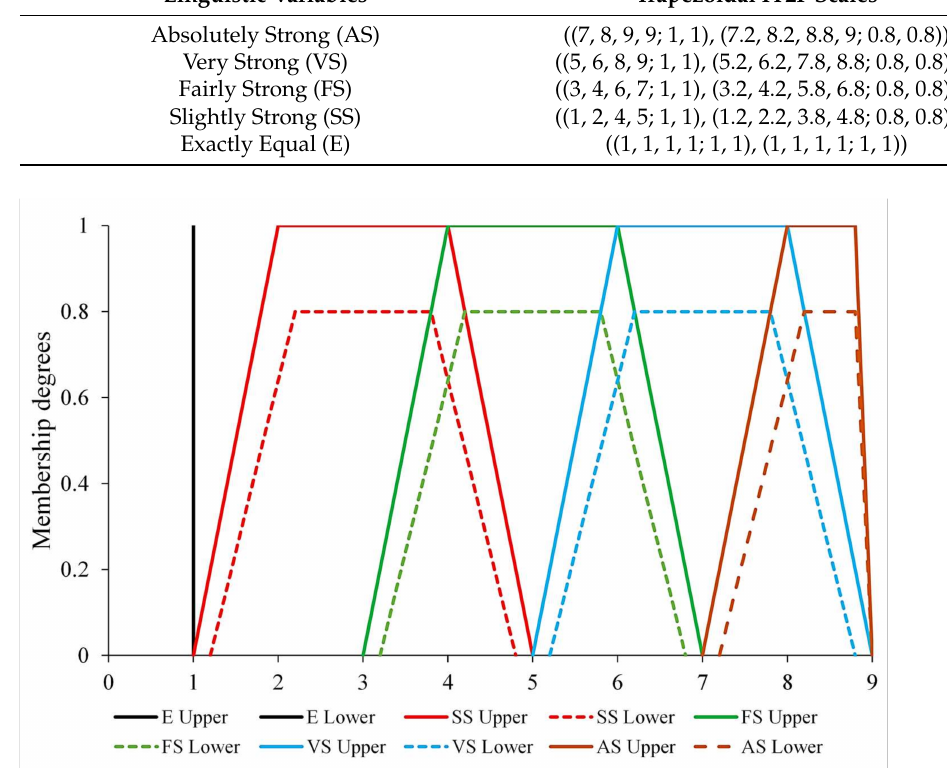
Figure 5. IT2F scales of the linguistic